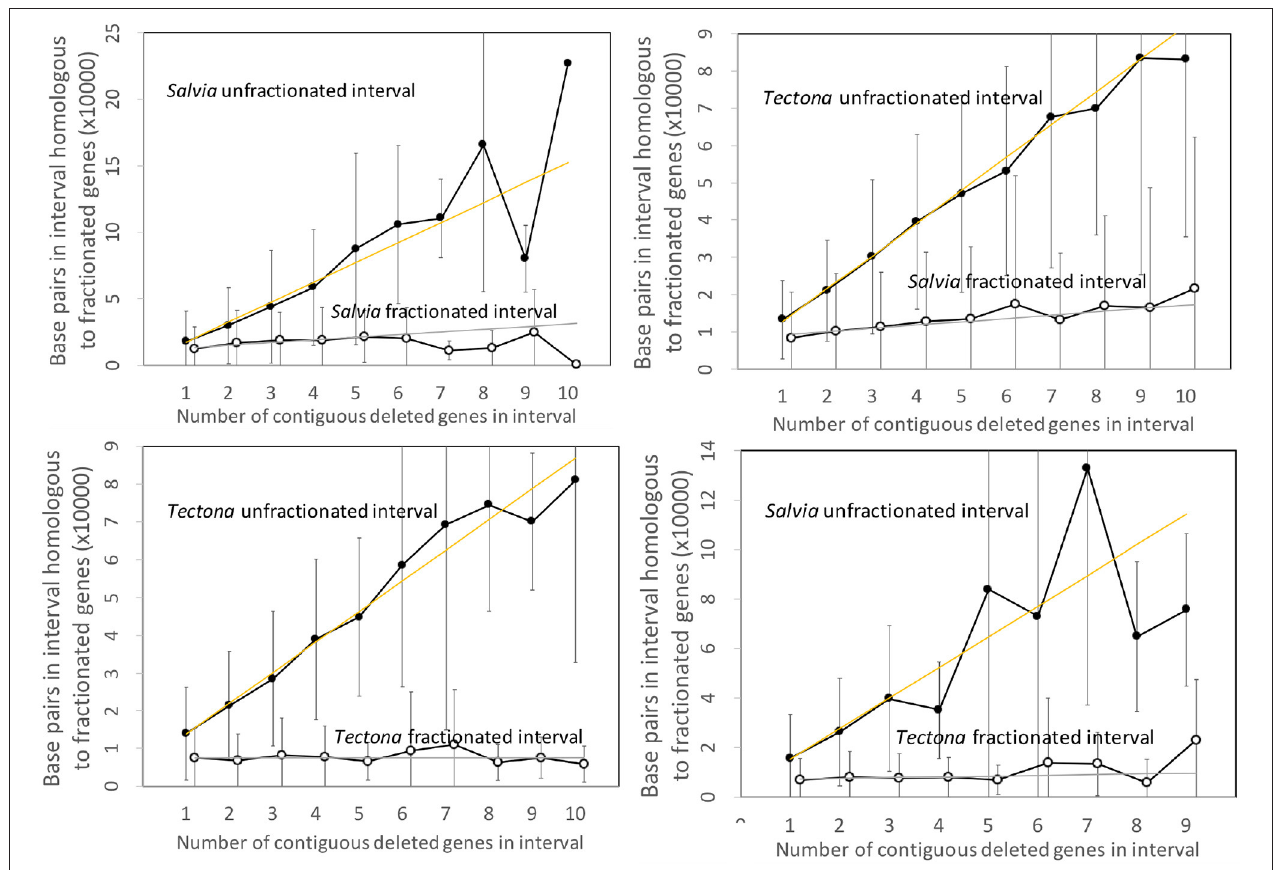
FIGURE 4 | Comparison of DNA content in unfractionated and fractionated intervals in the Salvia and Tectona